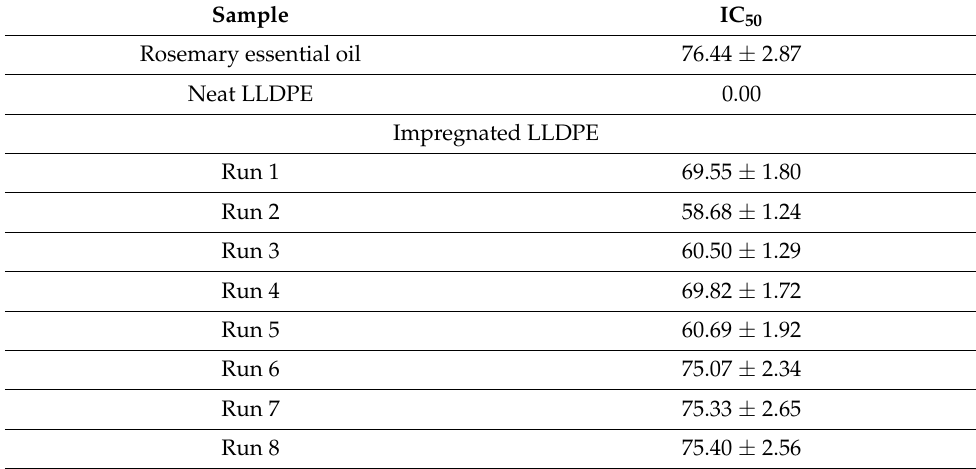
Table 6. IC 50 values using the DPPH method for rosemary essential oil and the impregnated LLDPE films. The results are presented as means ± SD (standard deviation) for triplicate assays.